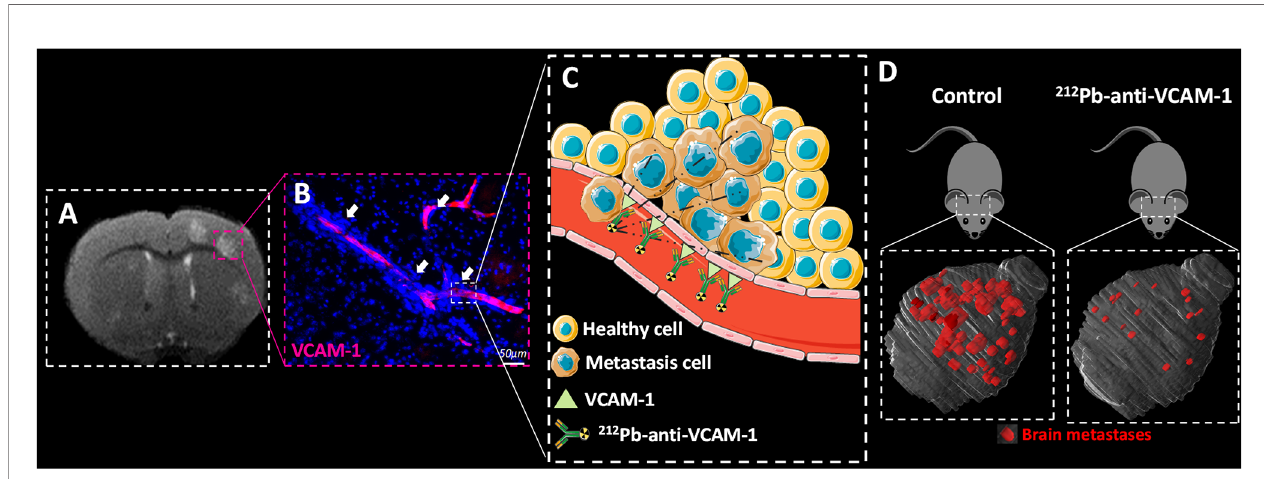
FIGURE 1 | RIT in early brain metastases. (A) MRI of a brain mouse with early brain metastases (BM). (B) VCAM-1 immunostaining showing the small distance between VCAM-1 activated endothelial cells and BM (pink staining and with arrow). (C) Representation of radioimmunotherapy targeting VCAM-1 for the early treatment of BM. (D) 3D representation of BM (red) in the brain (grey) in the control and 212Pb-anti-VCAM-1 treated